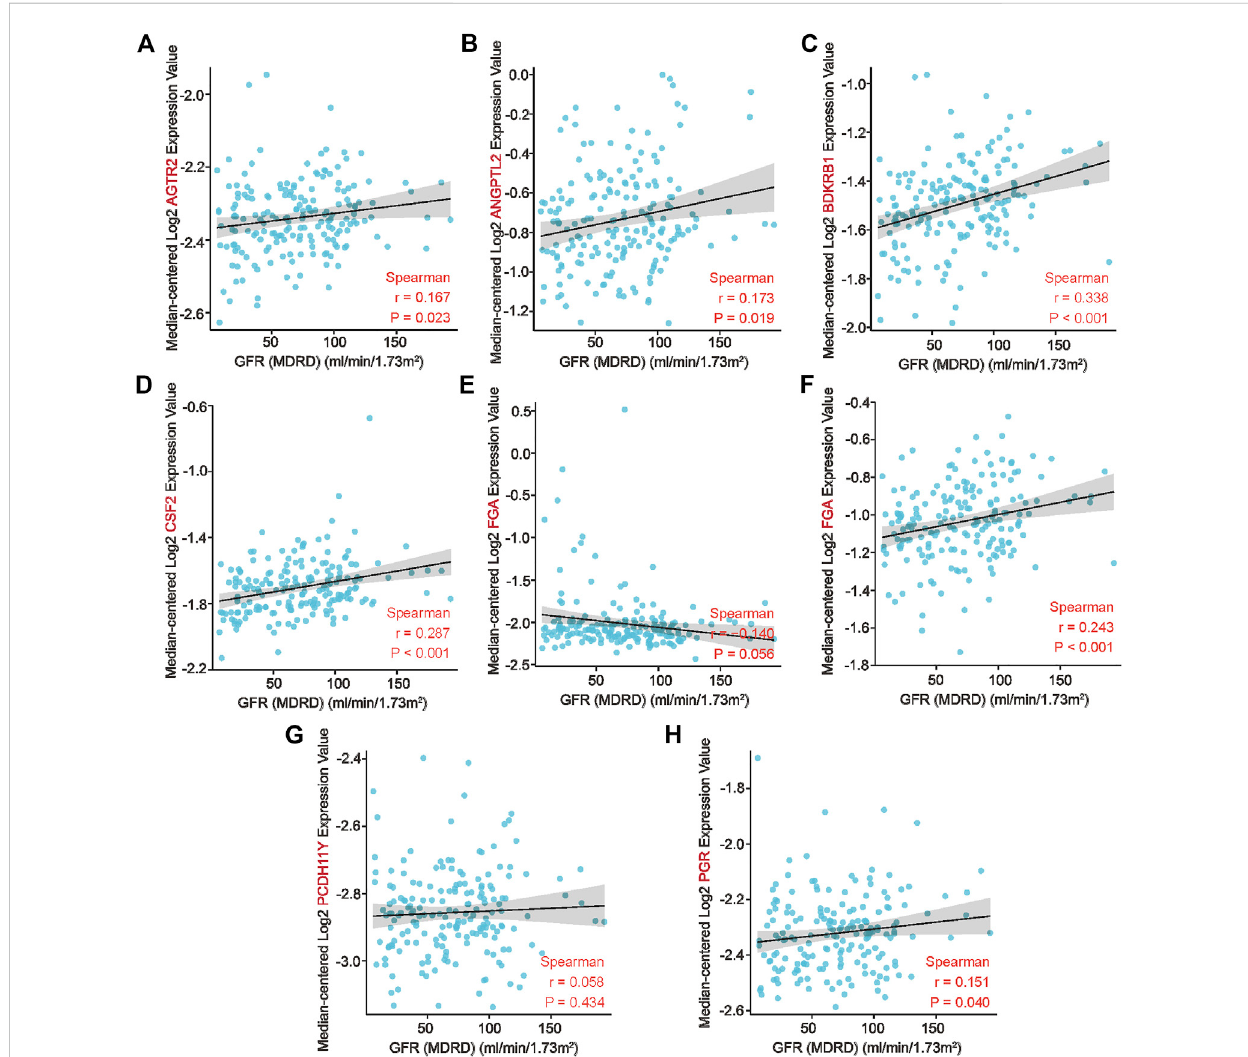
FIGURE 6 Association ofco – keygenesand clinical featuresintheNephroseqdatabase. (A – H) Correlation ofeight co-key geneswith theglomerular fi ltration rates of